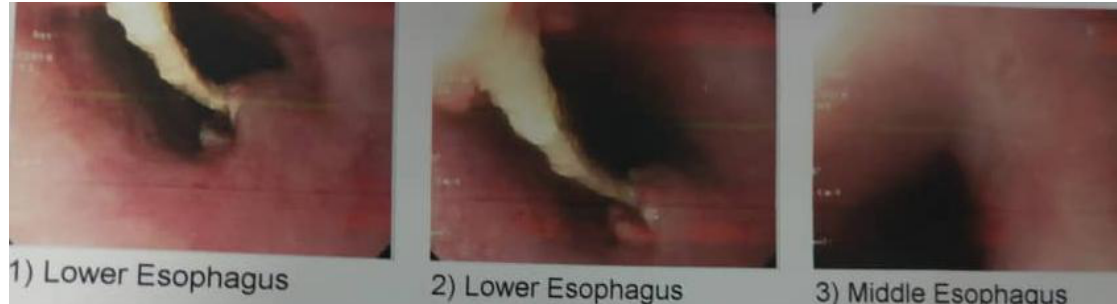
Figure 2. Endoscopic image showing a sharp chicken bone penetrating the esophageal